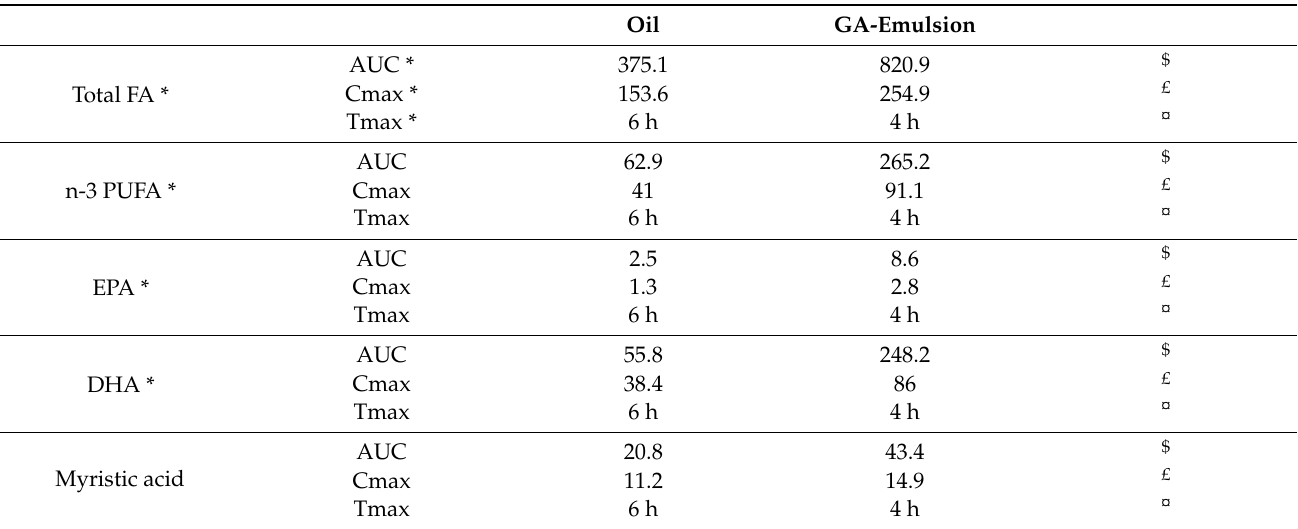
Table 4. Summary data for the maximal concentration (Cmax; mg/mL), area under the curve (AUC; mg/mL.h) and Tmax (h) for lymphatic main fatty acids in animals submitted to unemulsified versus emulsified oil.